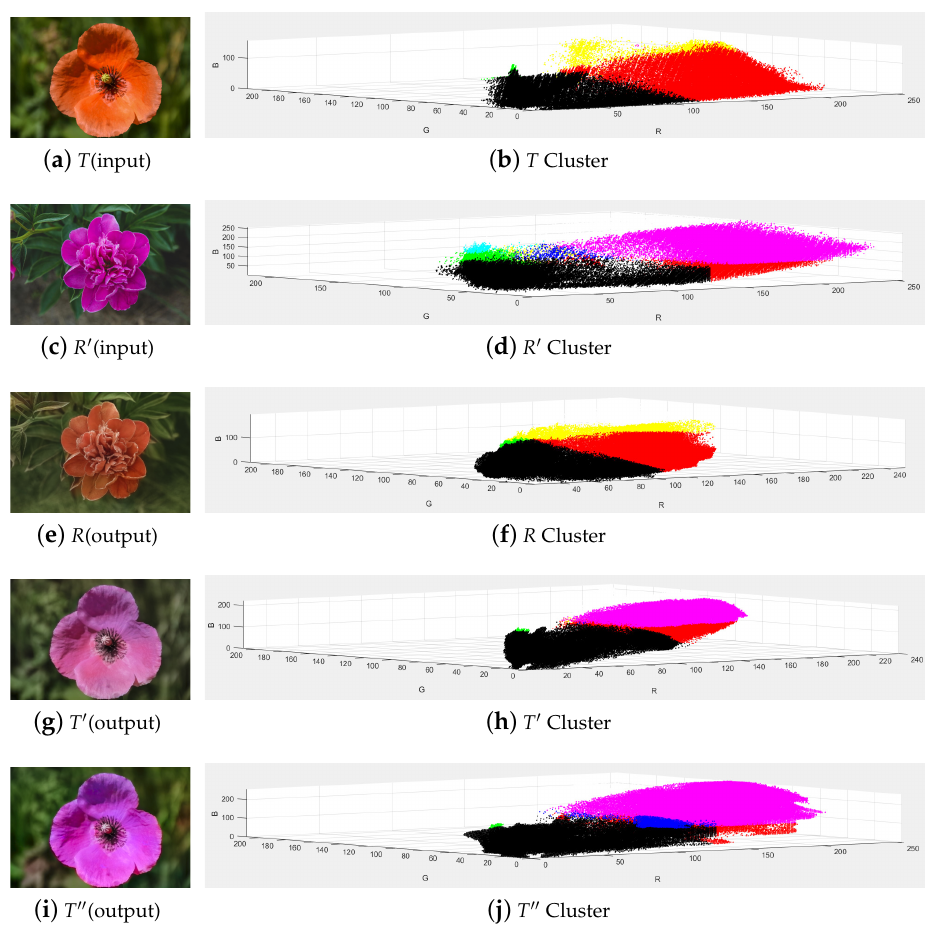
Figure 1. Color tranfer effect of